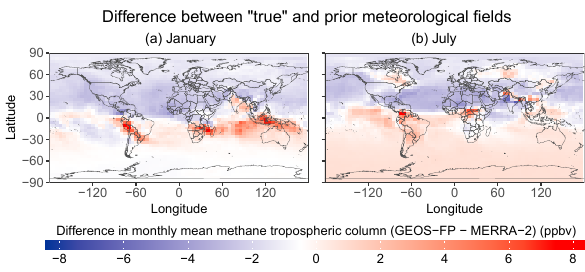
Figure 3. Differences in monthly mean methane dry air tropo- spheric column mixing ratios between two simulations with dif- ferent meteorological fields (GEOS-FP minus MERRA-2) for Jan- uary (a) and July (b) .